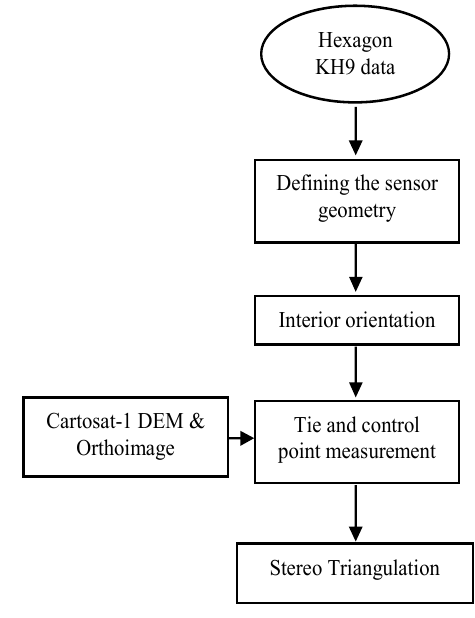
Figure 4. Orientation of Hexagon data through